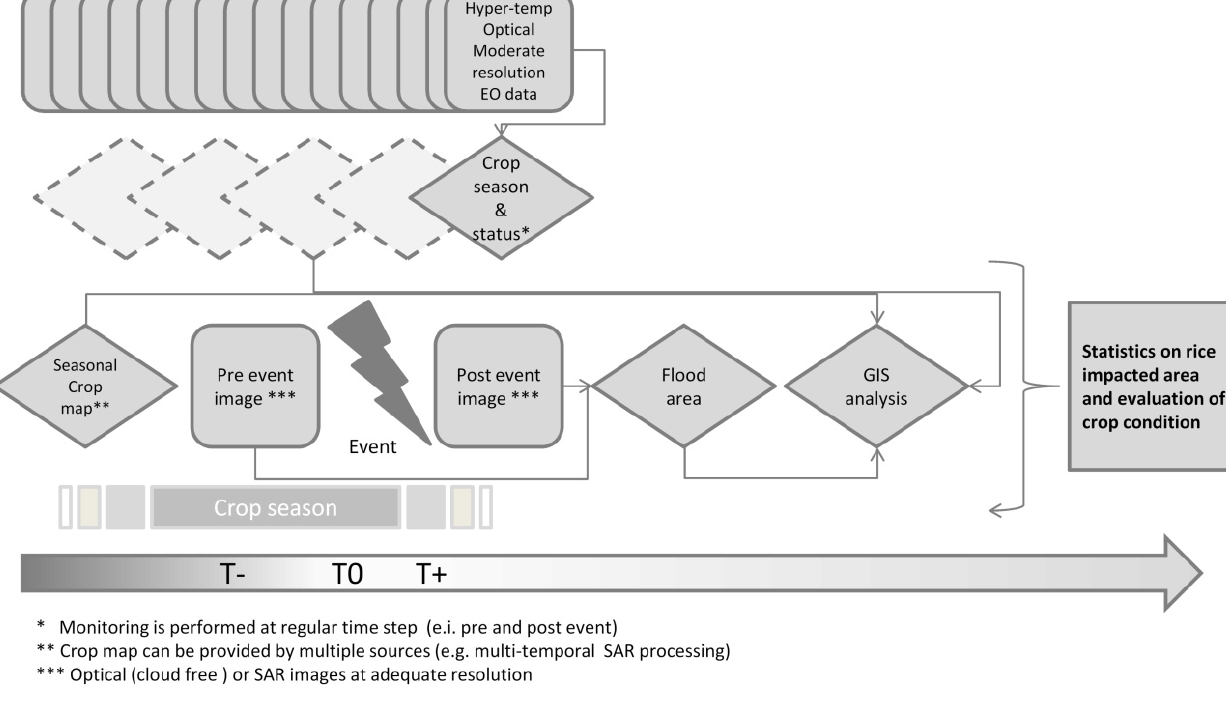
Figure 3. A combined proactive and reactive remote sensing approach to evaluate the risk of crop losses and the actual crop losses due to flooding from tropical